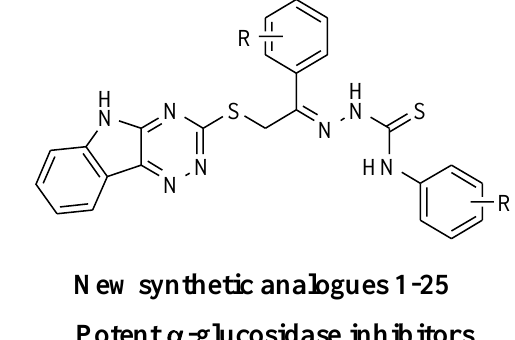
Figure 1. Rationale of the current work.